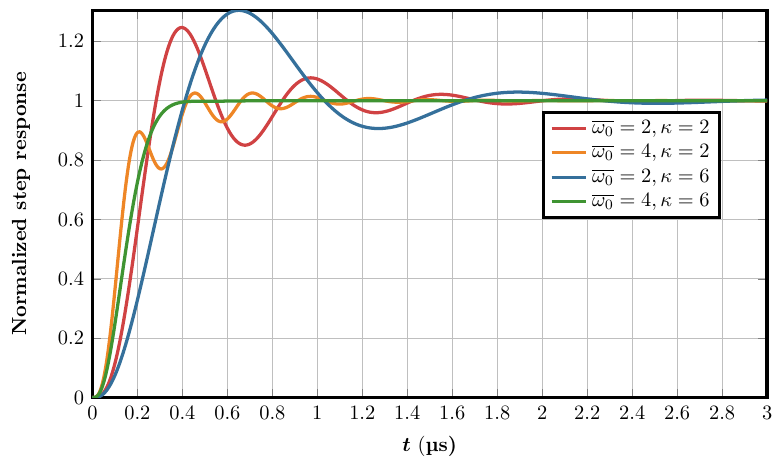
Figure 6. Unity-gain feedback step responses at different values of κ and ω 0 . Higher κ makes the compensation more